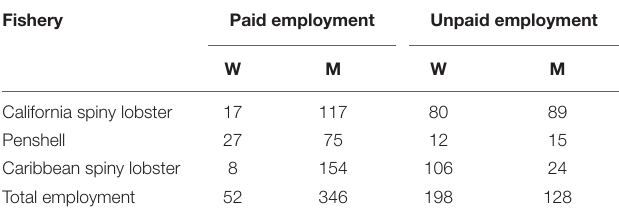
TABLE 5 | Paid and unpaid jobs disaggregated by gender in the three fisheries.